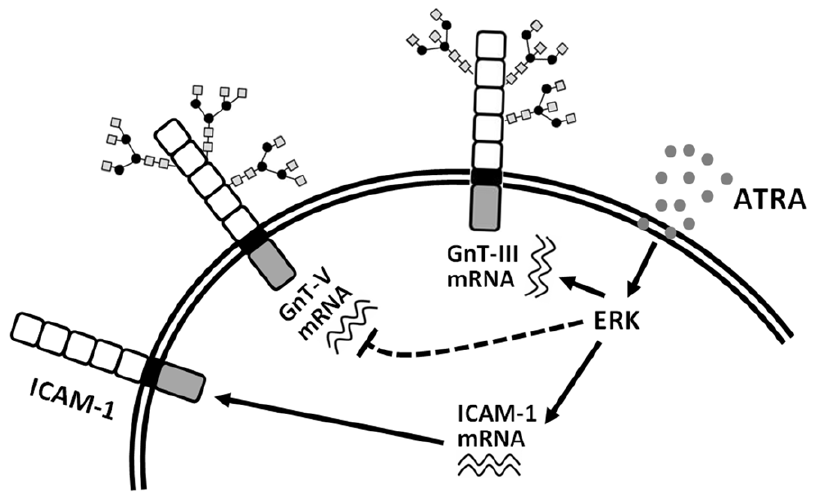
Figure 6. Schematic presentation of the mechanisms by which ATRA modulates the structure of N -glycans linked to ICAM-1.